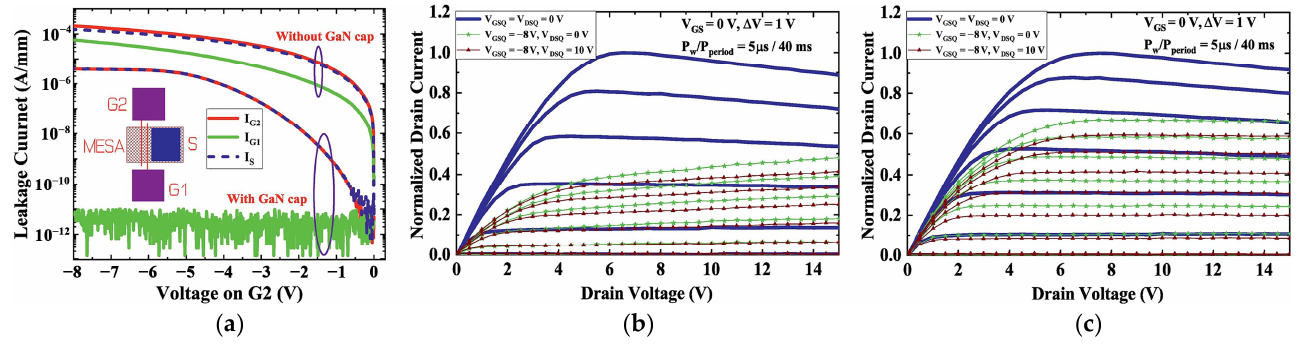
Figure 7. ( a ) Characteristics of the double gate. I s is the vertical leakage current through 2DEG, and I G1 is the horizontal leakage current by electron hopping between surface states. I G2 is the total leak- age current (I G2 = I S + I G1 ). Pulsed output characteristics of HEMTs, ( b ) without GaN cap, and ( c ) with GaN cap. Adapted with permission from Ref. [11]. Copyright 2022 by Elsevier. ( c ) with GaN cap. Adapted with permission from Ref. [11]. Copyright 2022 by